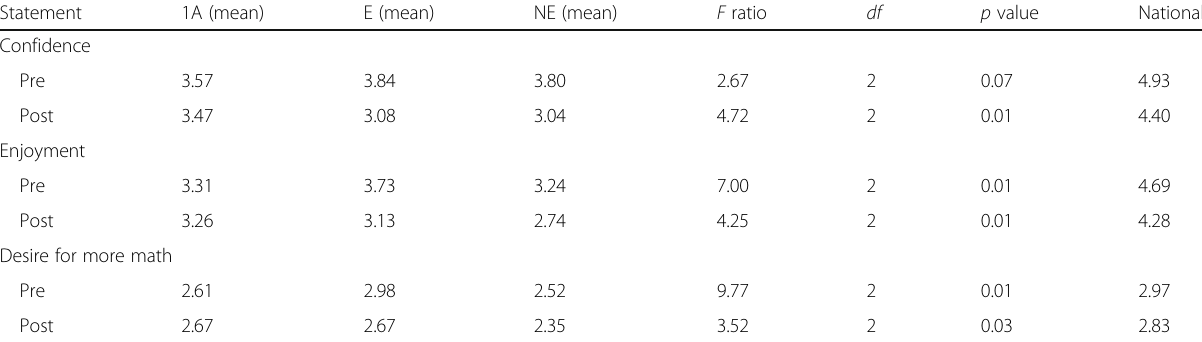
Table 6 Change in students ’ confidence, enjoyment, and desire for more mathematics